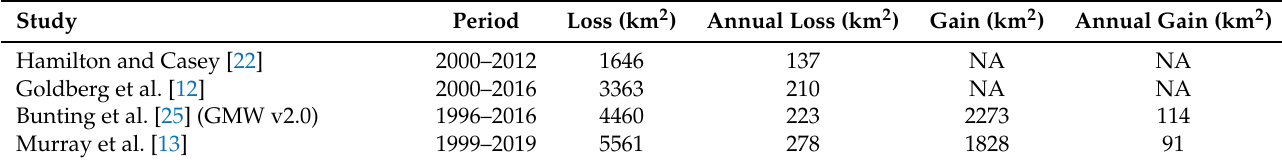
Table 1. Comparison of global mangrove change